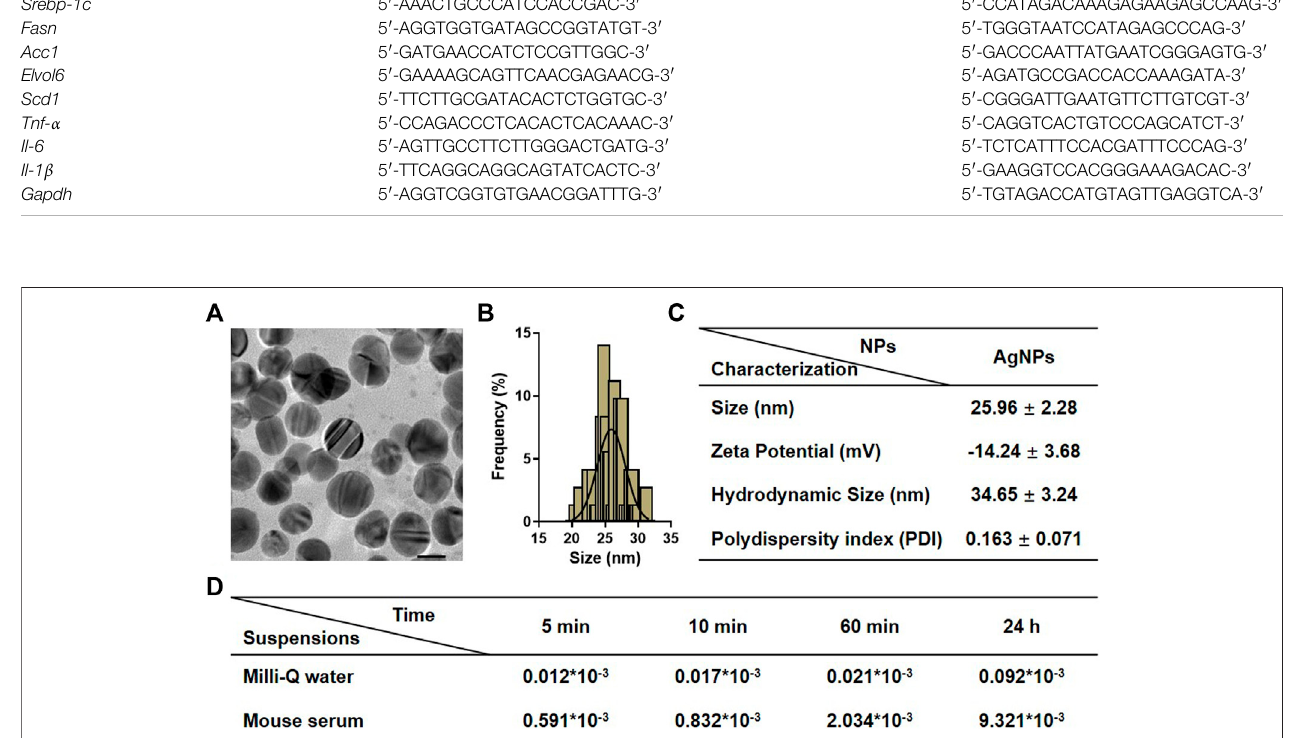
FIGURE 1 | Physicochemical characterization of silver nanoparticles (AgNPs). (A) Representative TEM images of AgNPs. (B) Size distribution of AgNPs measured by TEM. (C) The detailed information on physicochemical characterization of AgNPs includes size, zeta potential, hydrodynamic size, and polydispersity index (PDI). (D) Dissolution of AgNPs in originalstock suspensions and simulated biological conditions after incubation for 5, 10, 60 min, and 24 h. Results for ionic silver are expressed as a percentage of total silver measured in the stock